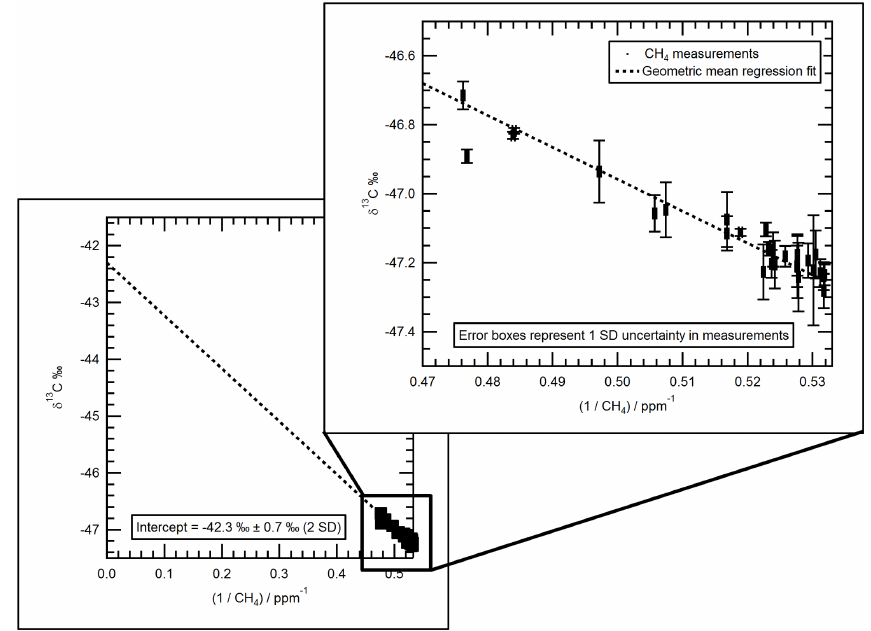
− 42.3 ± 0.7‰. (2 σ error: geometric mean regression). 4